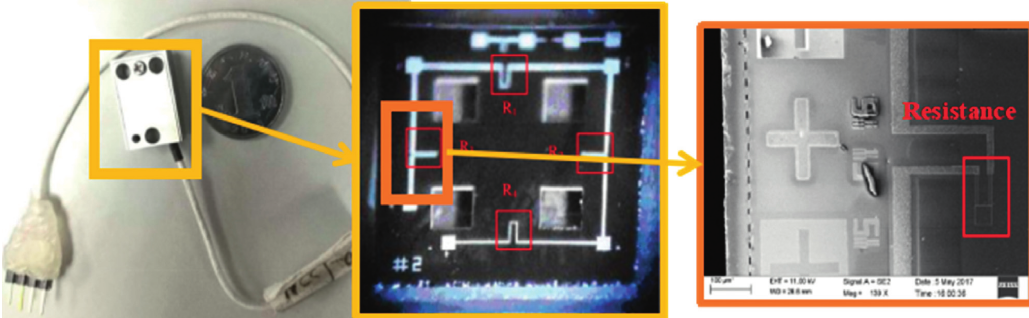
Figure 5: Overall picture, CCD picture, and SEM picture of the accelerometer.